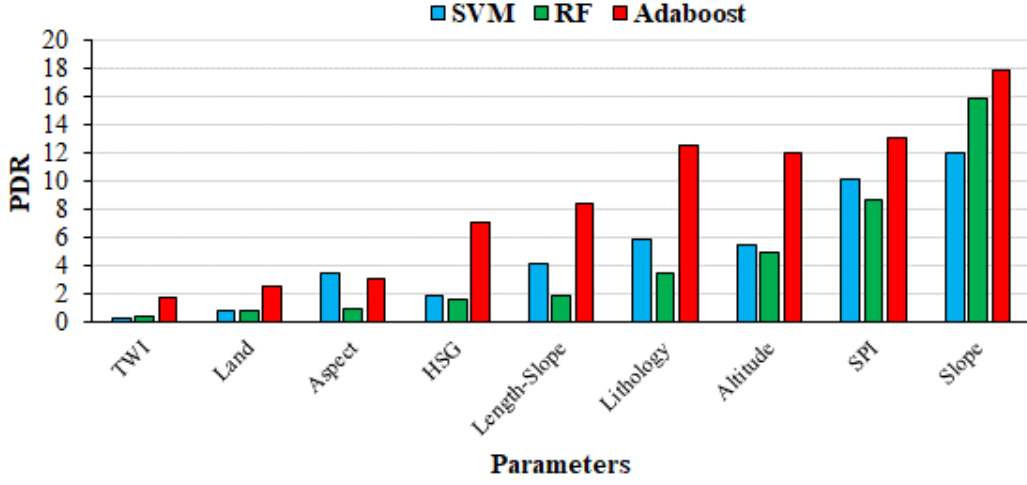
Figure 7. Sensitivity analyzing for each parameter using the Jackknife test for SVM, RF, and AdaBoost.